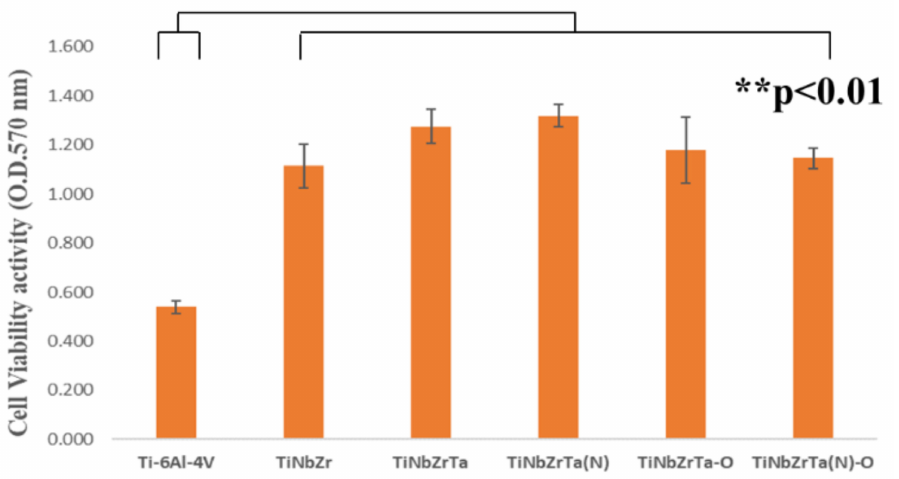
Figure 6. Cell viability analysis of L-929 cells cultured on uncoated Ti-6Al-4V and TiNbZrTa series films for 48 h. ** represents significance among groups ( p <